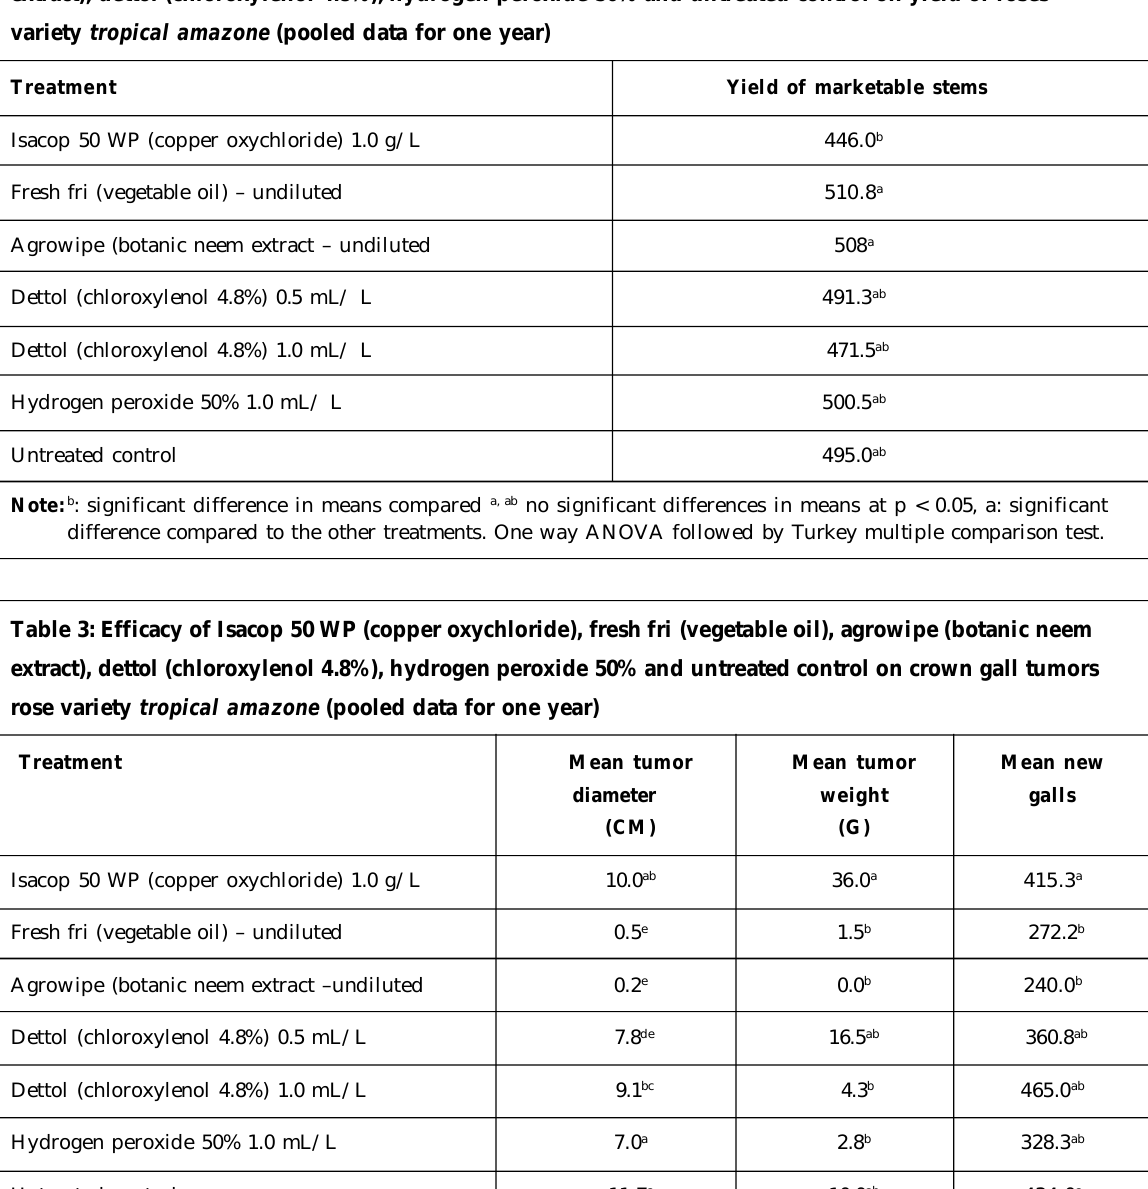
Table 2: Efficacy of Isacop 50 WP (copper oxychloride), fresh fri (vegetable oil), agrowipe (botanic neem